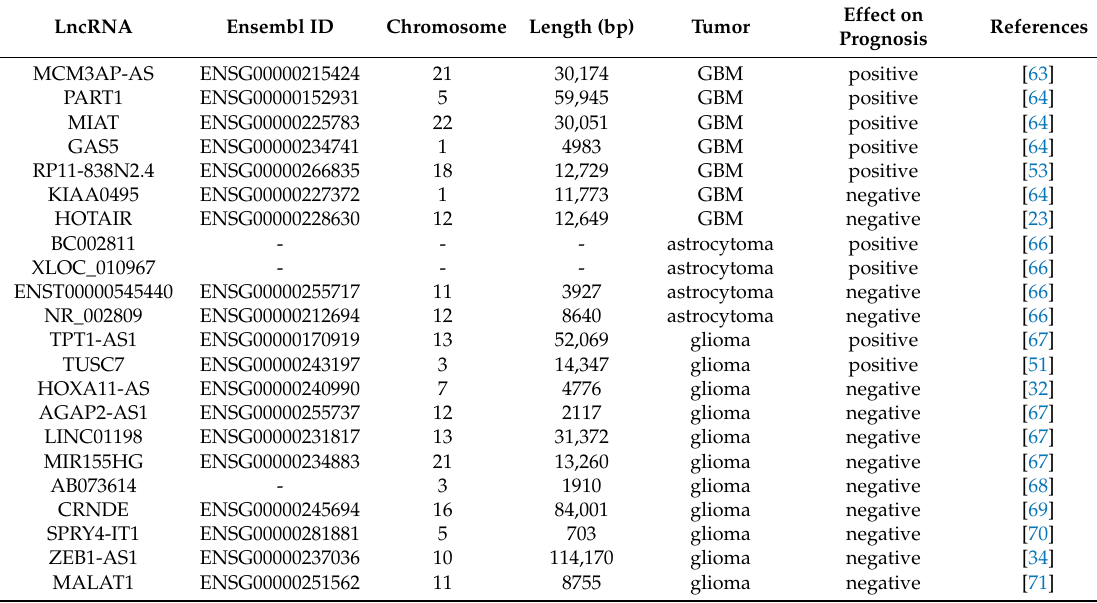
Table 2. LncRNAs with prognostic potential in